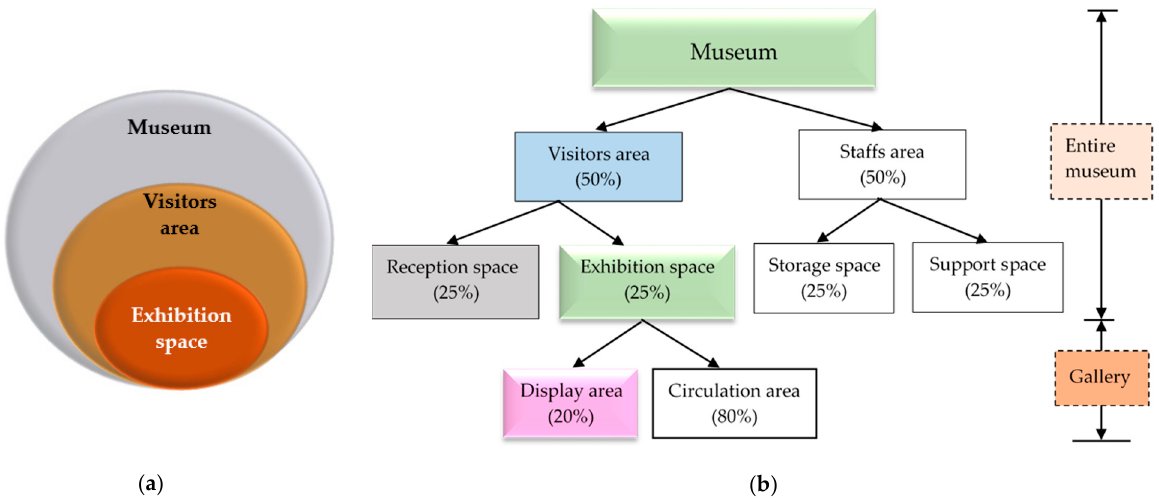
Figure 1. The multilayered environment of a museum (this study): ( a ) exhibition space is the core area of a museum; ( b ) concept tree of each function area and percentage in museums. Table 3. Museum space function and proportion.